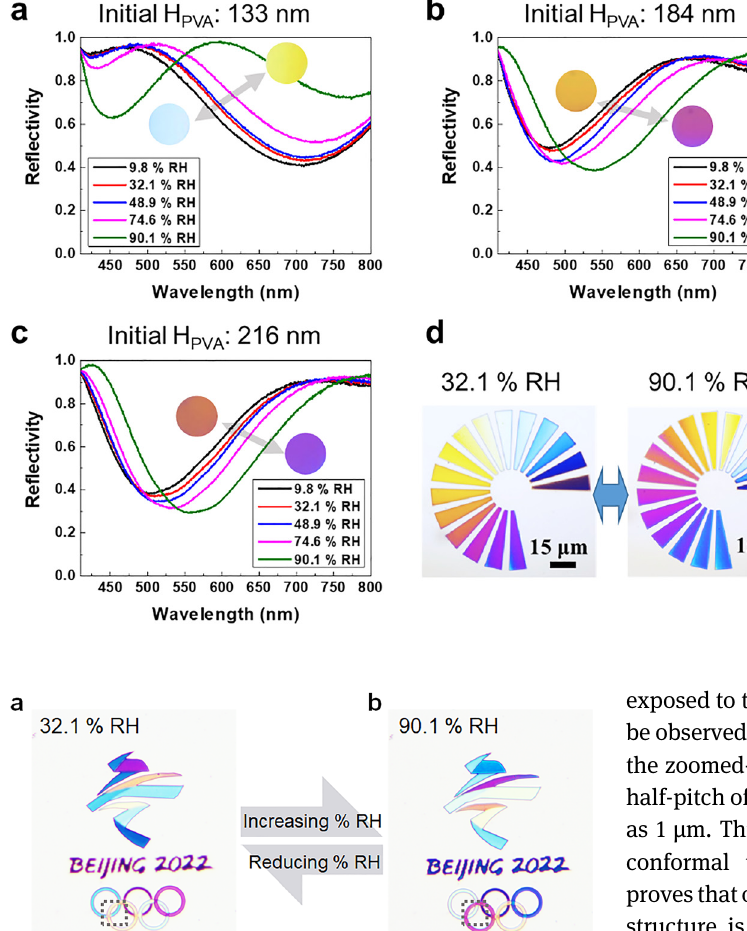
Figure 5: Logo pattern of the Beijing 2022 olympic games which is tunable by switching humidity between 32.1 and 90.1%